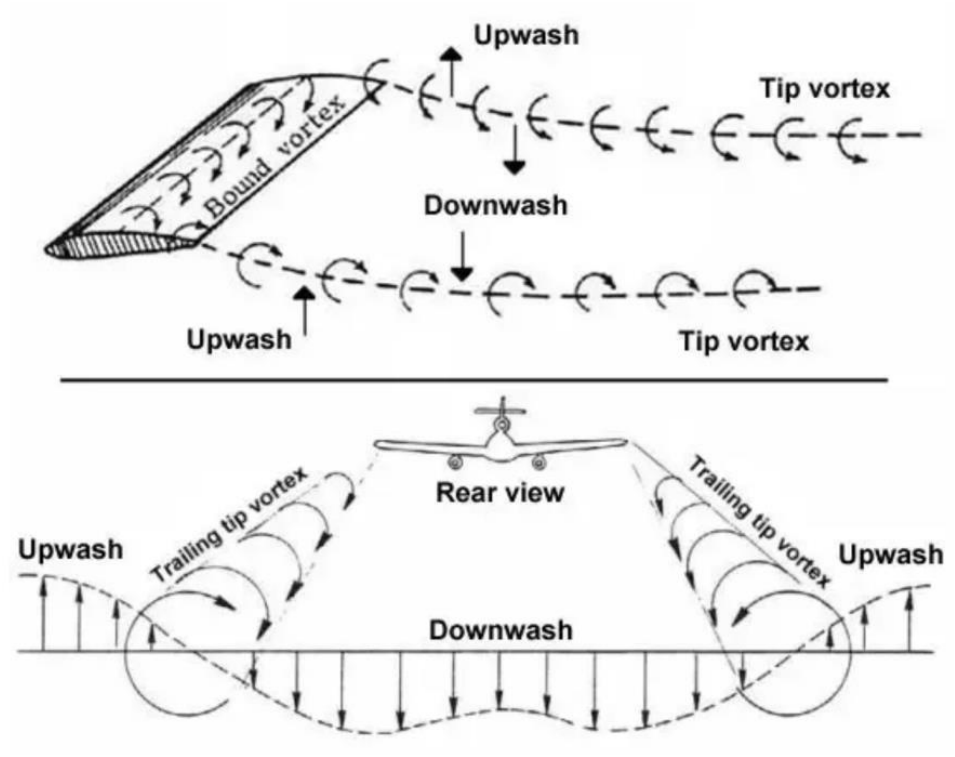
Figure 1. Downwash and upwash generation from wingtip vortices [11].